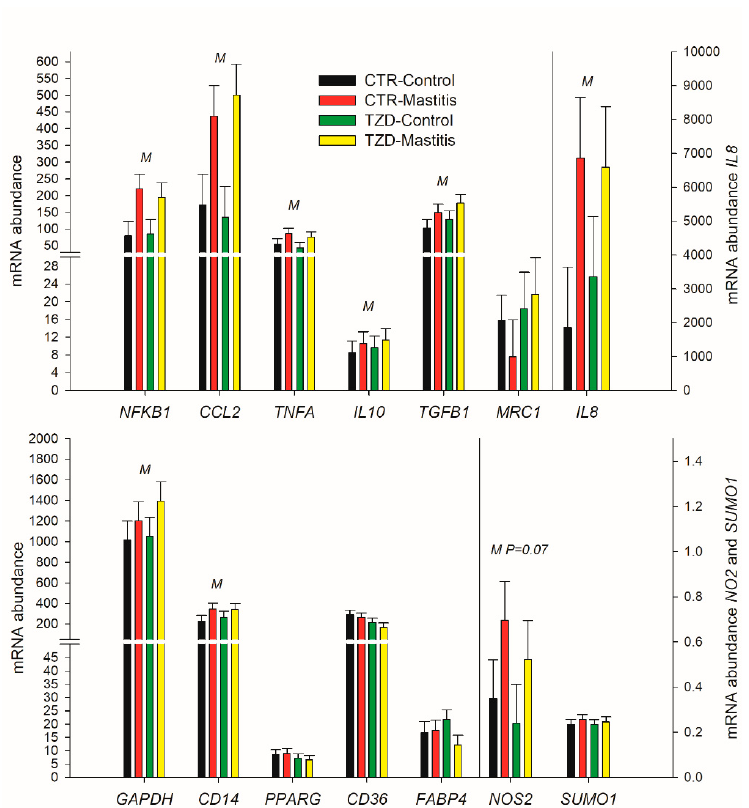
Figure 8. Effect on expression of genes related to classical ( NFKB1 , TNFA , CCL2 , NOS2 , and IL8 ) or alternative ( MRC1 ) macrophages activation, macrophages deactivation ( IL10 , TGFB1 ), and metabolism in macrophage isolated from the milk of Saanen goats receiving either intrajugular daily injection of 2,4-thiazolidinedione (TZD) or saline (CTR) and intramammary infusion in the right half of the mammary gland of Strep. uberis (Mastitis) while the left half of the mammary was left untouched (Control). Cells were isolated 5 days post-intramammary infection (IMI). Letters in the plot denote overall statistical ( p ≤ 0.05) effect for IMI (M), 2,4-thiazolidinedione treatment (Z), or interaction (M × Z). When a tendency was detected, the P-value is reported.